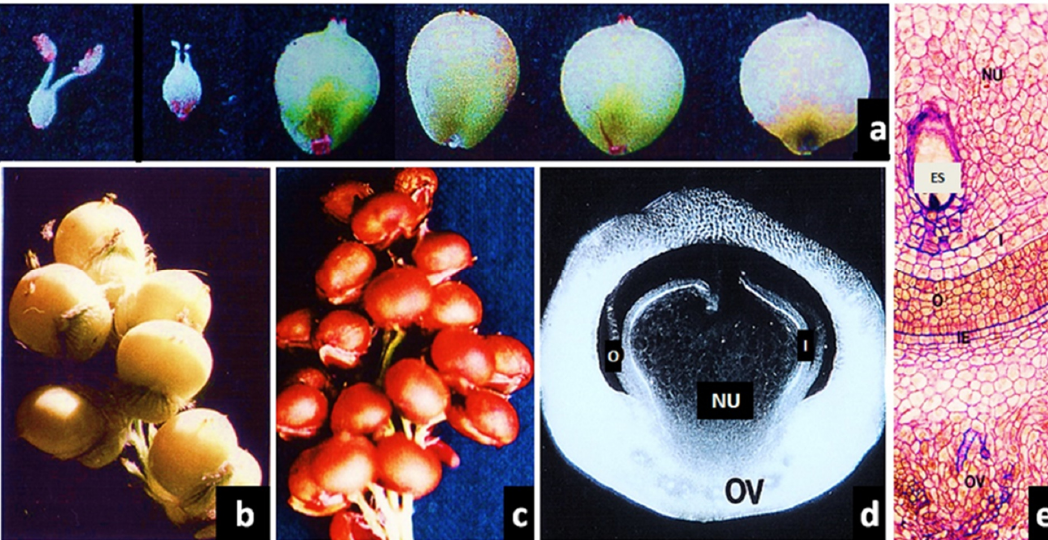
Figure 1. (a) Ovary at anthesis and caryopsis after 1, 10, 15, 25 and 30 DAF The ovary is about 1 mm long and the mature grain about 5 mm long. The small pad of crease tissue region is seen in all four later stages. (b) Mature spikelets with 30-day-old grains. (c) Spikelets of cv. ‘Framida’ with mature grains. Colour is due to tannin in pericarp and inner integuments. (d) Free hand transverse section (T.S.) of young ovary photographed between crossed polarizers. Pericarp, integuments, vascular traces and nucellus are seen. 60x. (e) Plastic thin section of pre-anthesis ovary stained with Toluidine Blue O showing cellular details. At this level the outer integument is multilayered.